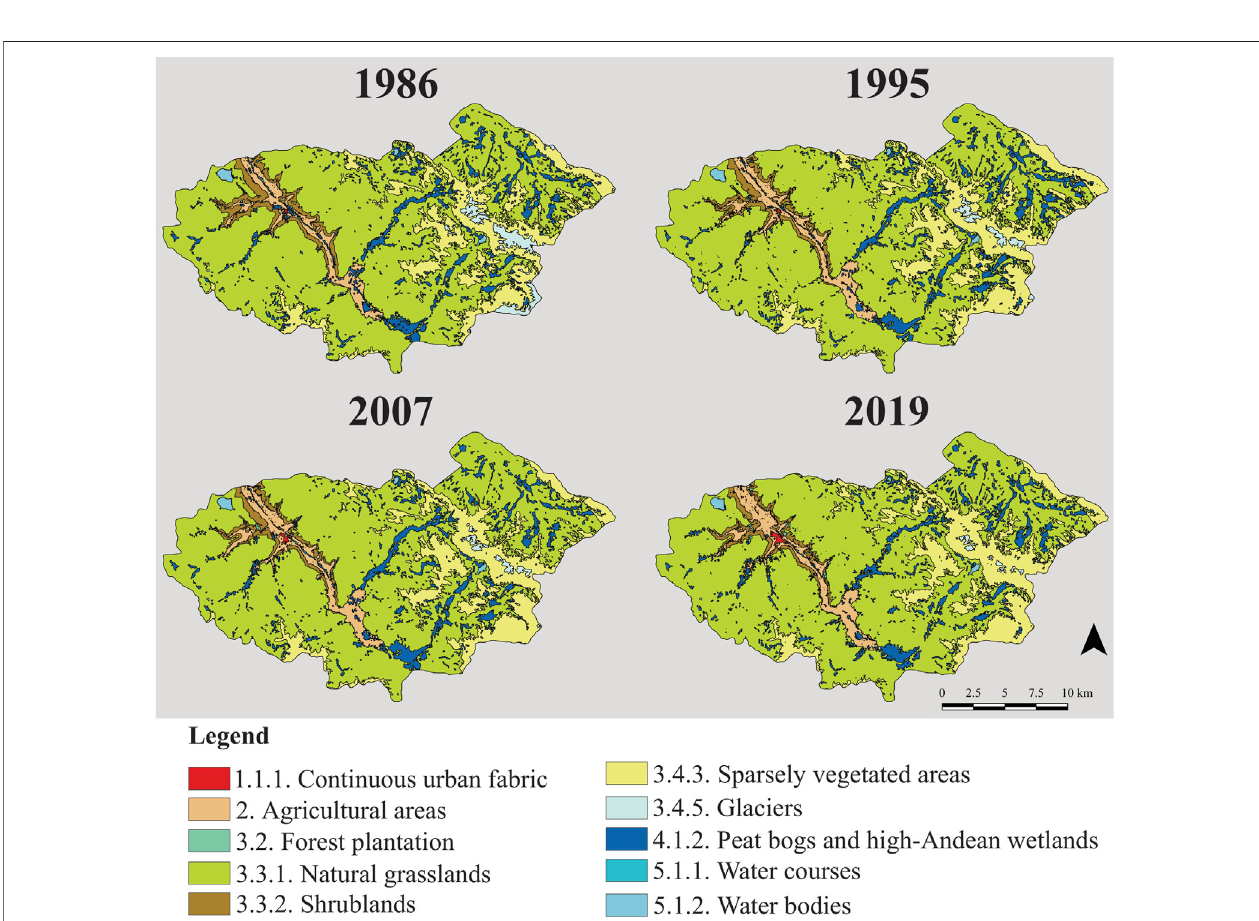
FIGURE 2 | Maps of the spatial distribution of LULC for Marangani municipality over the 4 years.